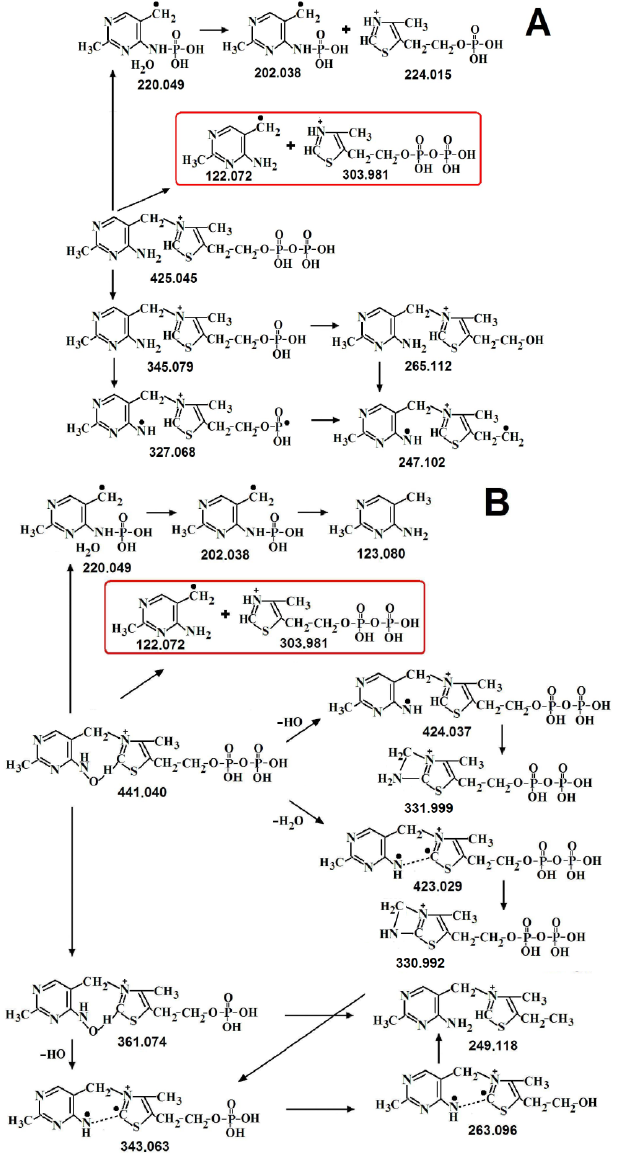
Figure 5. Proposed fragmentation of ThDP ( A ) [16] and ThDP-O ( B ). In red boxes are fragments formed when the molecule is broken in half. Table 4. MS/MS fragments of ThDP and ThDP-O.